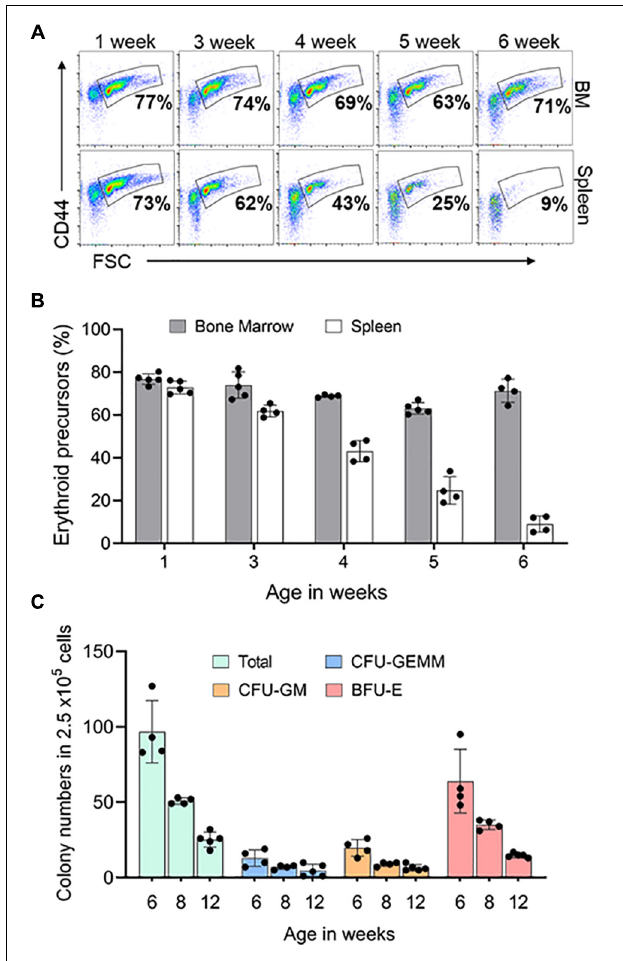
FIGURE 5 | Postnatal spleen erythroid precursors and progenitors. (A) Representative FACS plots showing expression of Ter119 + erythroid precursors from bone marrow and spleen based on CD44 expression and size (FSC-forward scatter). The gated region shows the percentage of erythroid precursor cells. (B) Quantification of erythroid precursors within Ter119 + cells over time (C) Methylcellulose colony forming assay of the spleen at three time points. Data represented as mean ± SD; n = 4–5 mice per group in two independent